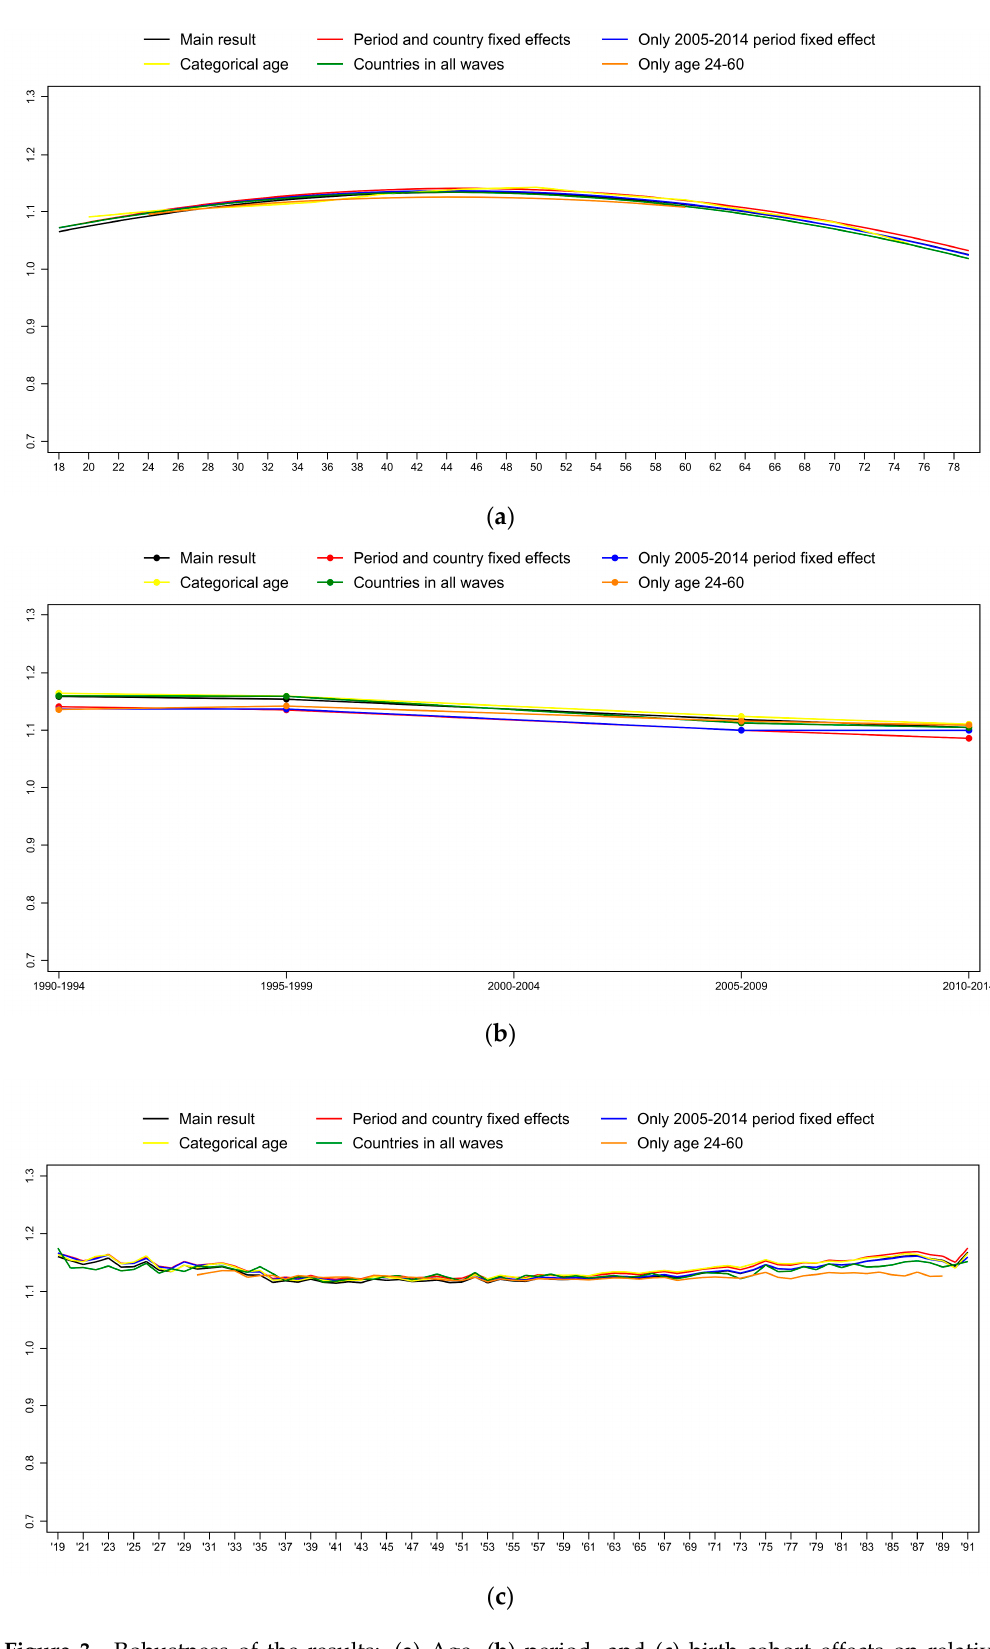
Figure 3. Robustness of the results: ( a ) Age, ( b ) period, and ( c ) birth-cohort effects on relative importance of work (hierarchical age-period-cohort regression models). The y -axis shows the predicted value of the dependent variable (for an average respondent).